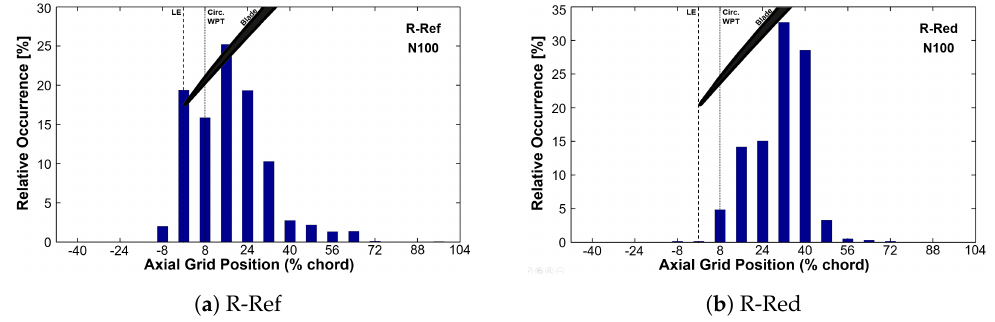
Figure 7. Relative Occurance of Aerodynamic Disturbances at Design